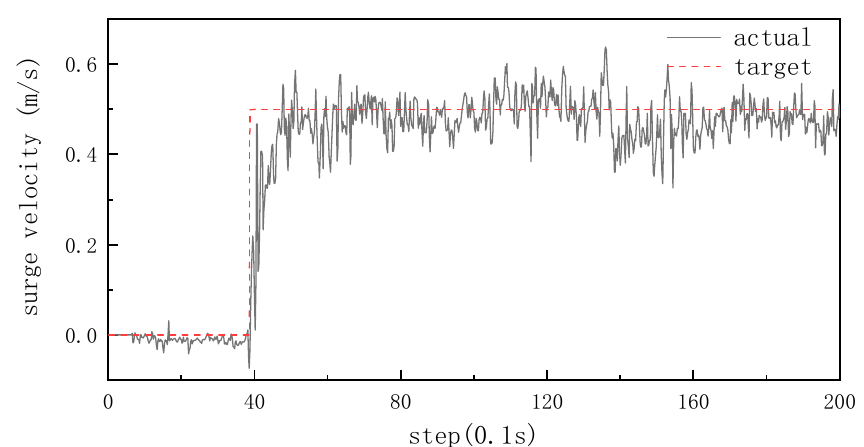
Figure 17. Automatic control of the velocity.